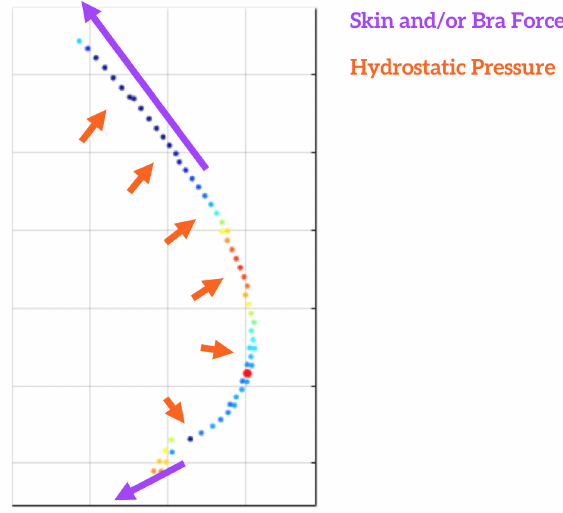
Figure 5. Diagram of forces considered in FDM